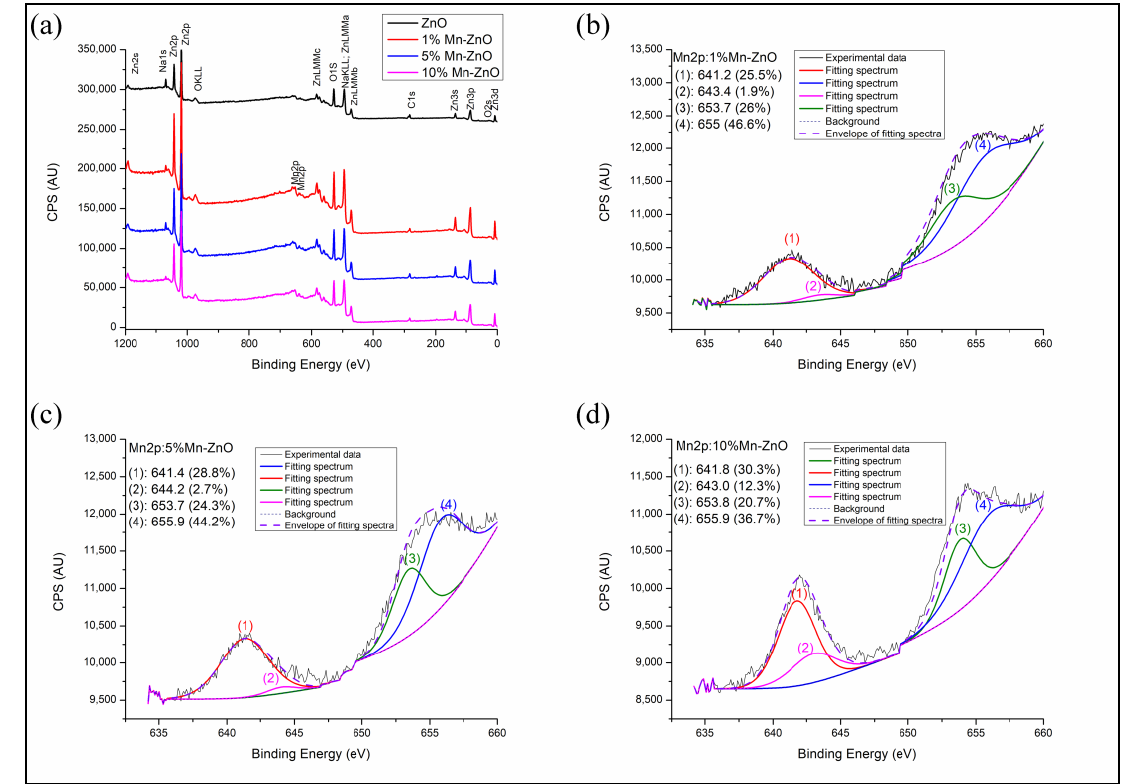
Figure 4. Full scan ( a ) and High-resolution XPS spectra of Mn2p in the synthesized 1%Mn-ZnO ( b ), 5%Mn-ZnO ( c ) and 10%Mn-ZnO ( d ) nanomaterials.